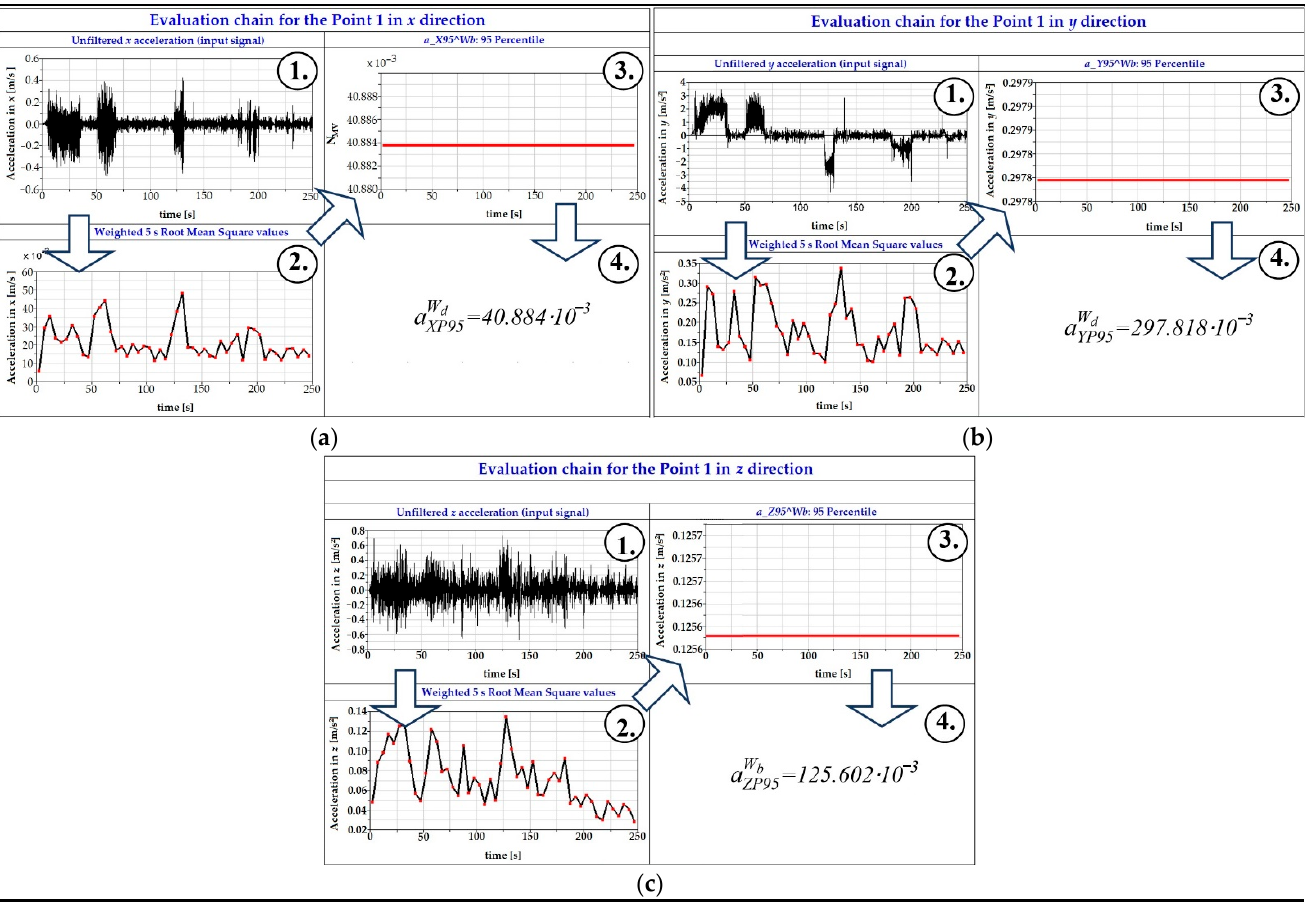
Figure 4. The procedure of processing acceleration signals in the Simpack software postprocessor: ( a ) for the x direction; ( b ) for the y direction; ( c ) for the z direction.